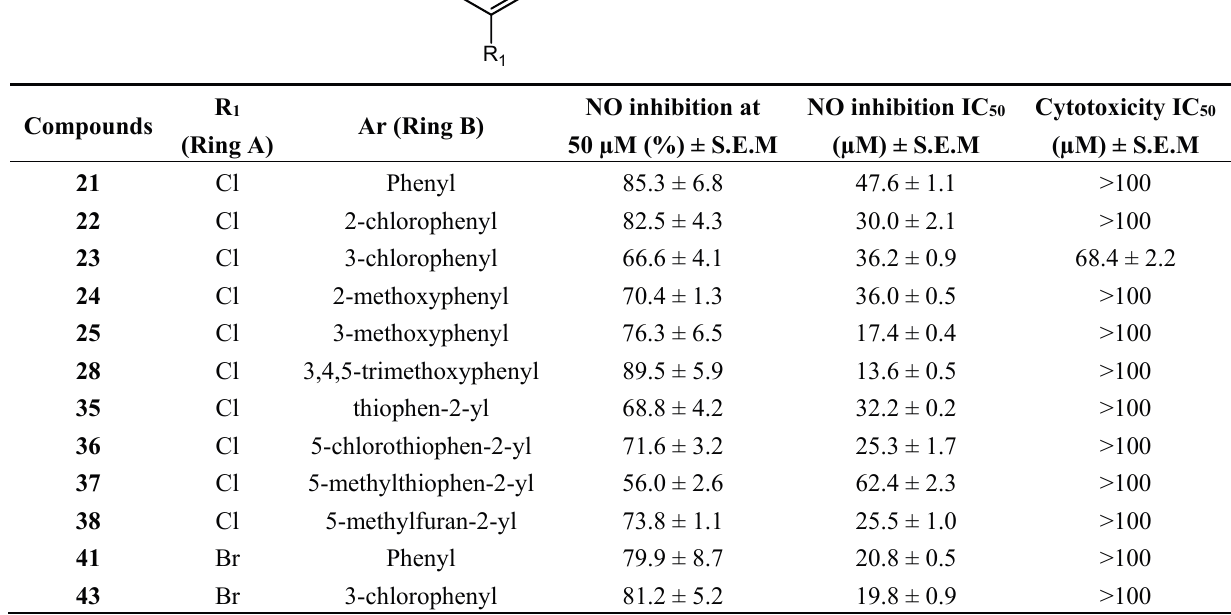
Table 3. NO suppression activity and cytotoxicity of active compounds in methoxylated diarylpentenedione series on RAW 264.7